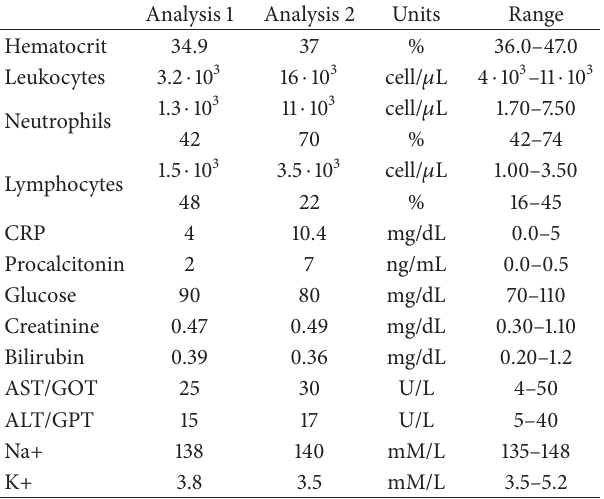
Table 1: Blood count and biochemical analysis in peripheral blood. Analysis